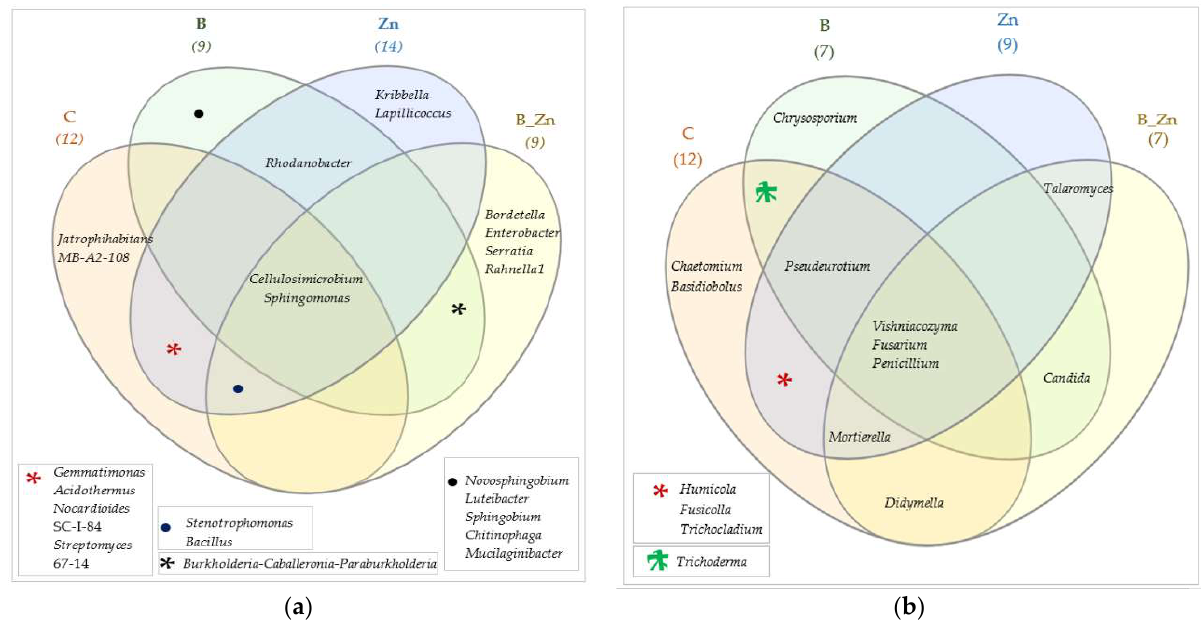
Figure 11. Venn diagram showing unique and common types of bacteria ( a ) and fungi ( b ), based on OTU ≥1%; C—uncontaminated soil; B—bisphenol A; Zn—ion zinc (Zn 2+ ).